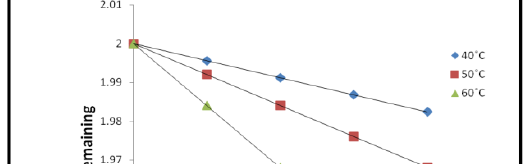
Figure7:Dissolution profile of selected aspirin formula from bilayer tablet in 0.1N HCl and 37˚C.